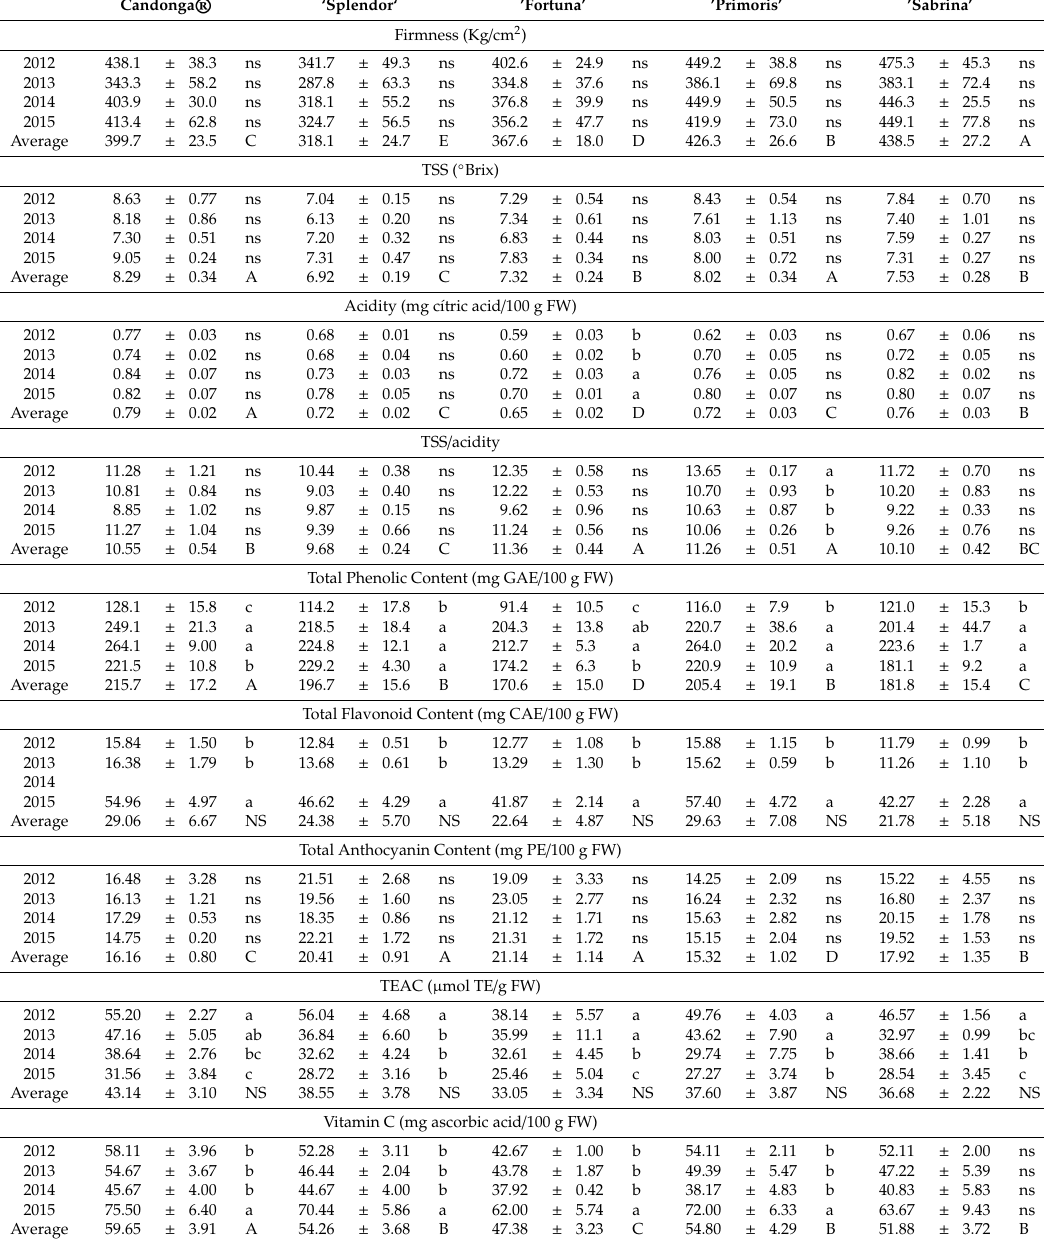
Table 2. Inter-annual variation of the organoleptic and functional fruit quality parameters in the five strawberry varieties. Each value is the mean ± SE for each year regardless of the harvest time. Lowercase letters indicate significant di ff erences between years on each variety, and capital letters indicate significant di ff erences between varieties ( p <